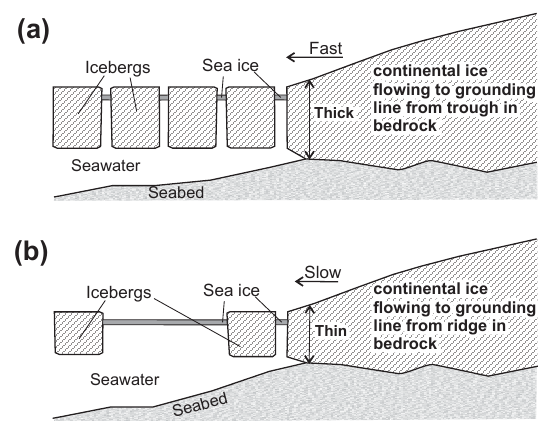
Figure 8. Illustration of the origin of the two different structures within the Brunt Ice Shelf. (a) Ice flowing out of a subglacial trough at around 100ma − 1 breaks up into closely packed icebergs sepa- rated by narrow channels in which sea ice forms. (b) Where thinner ice flows over the grounding line at a slower rate, the supply of ice is insufficient to match the flow speed of the ice shelf (which is driven by the faster ice coming out of the troughs), so the structure com- prises thin, widely spaced icebergs separated by wide expanses of sea ice.